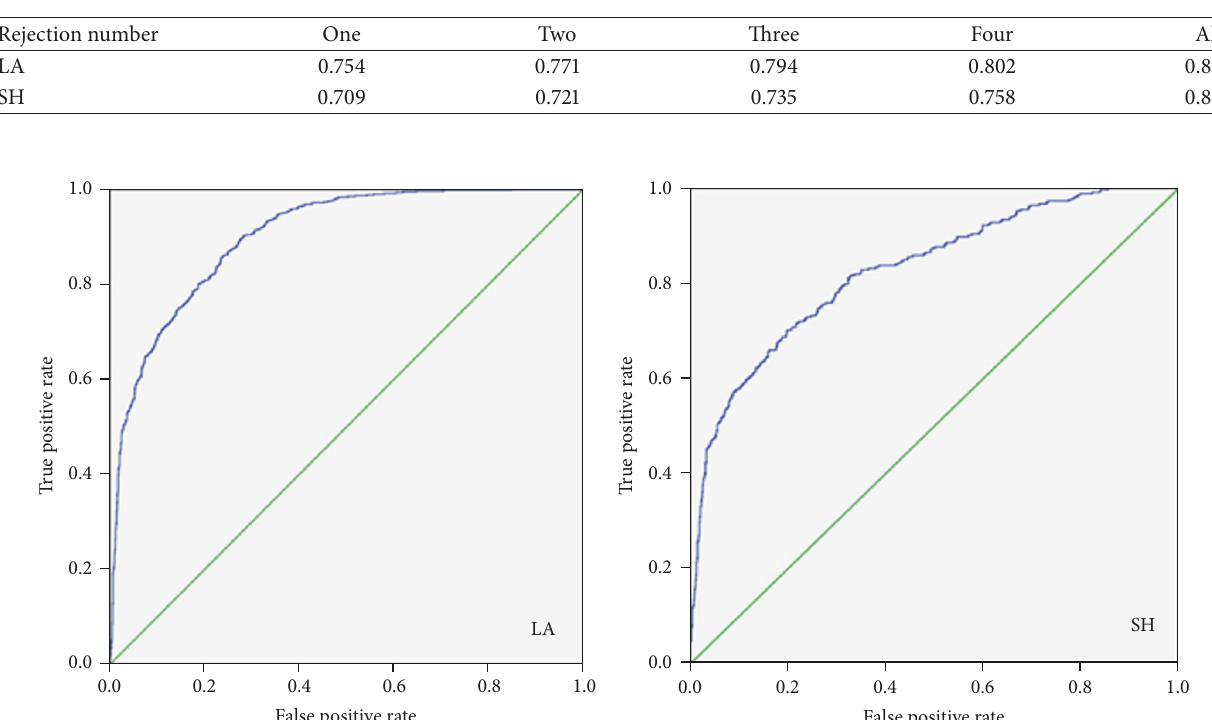
Figure 10: ROC curves of two sites (true positive rate [sensitivity] represents the probability of predicting an accepted state as an accepted state, while false positive rate [1 − specificity] is the probability of predicting a rejected state as an accepted state).